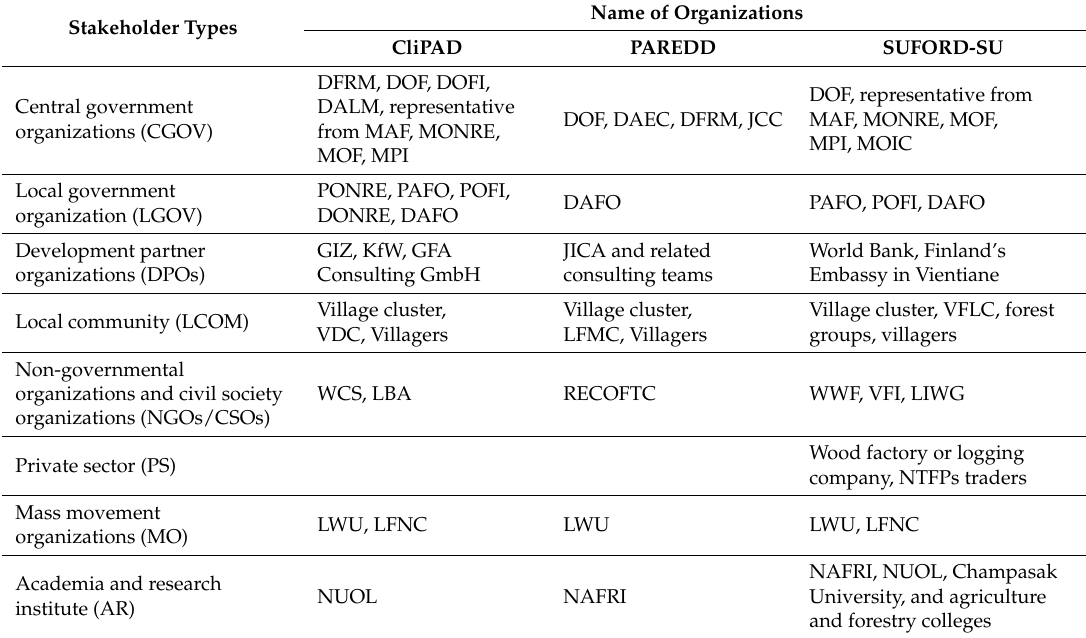
Table 2. Types of stakeholders in the